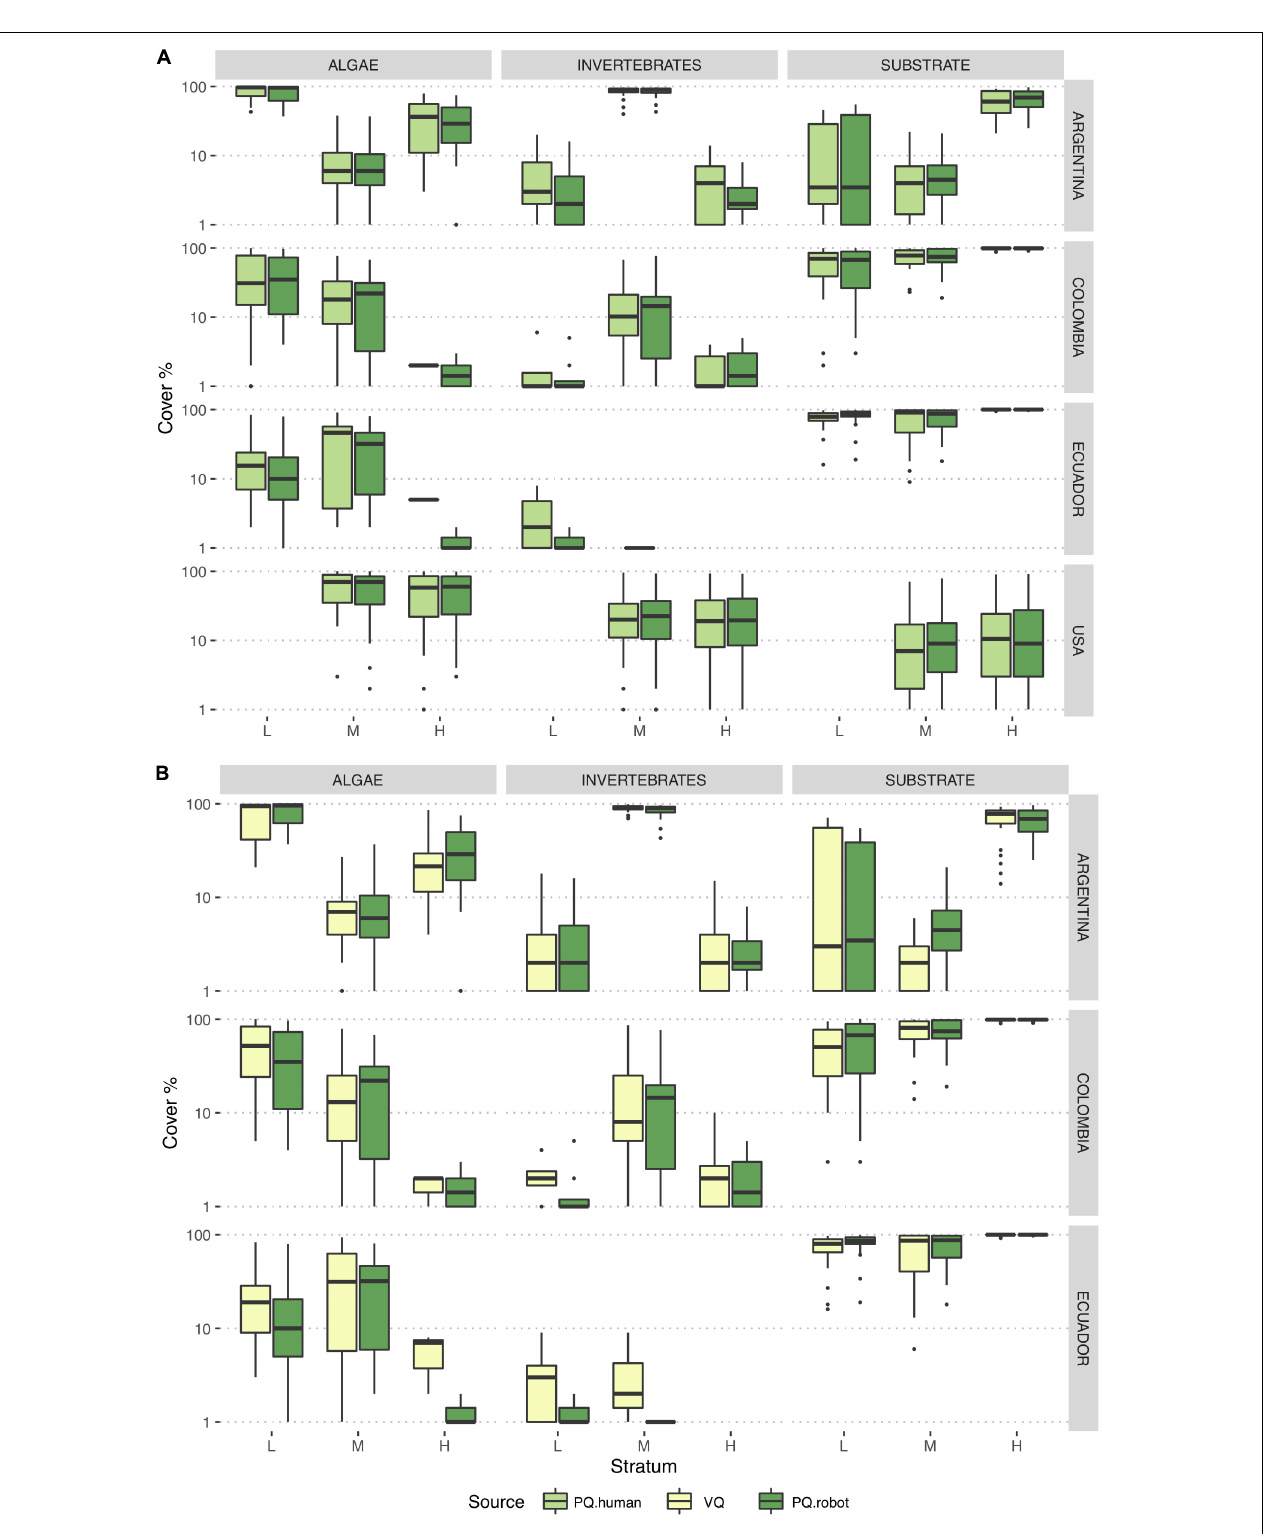
FIGURE 3 | Boxplots showing percentage cover by tidal level in each country for algae, substrate, and invertebrates. The horizontal bar within boxes represents the median, the lower and upper boxes represent the 25th and 75th percentiles, and the whiskers the 5th and 95th percentiles. Black dots represent outliers values above the 95th percentile. (A) PQ.human vs. PQ.robot, (B) VQ vs. PQ.robot. L, low tide level; M, mid tide level; H, high tide level.